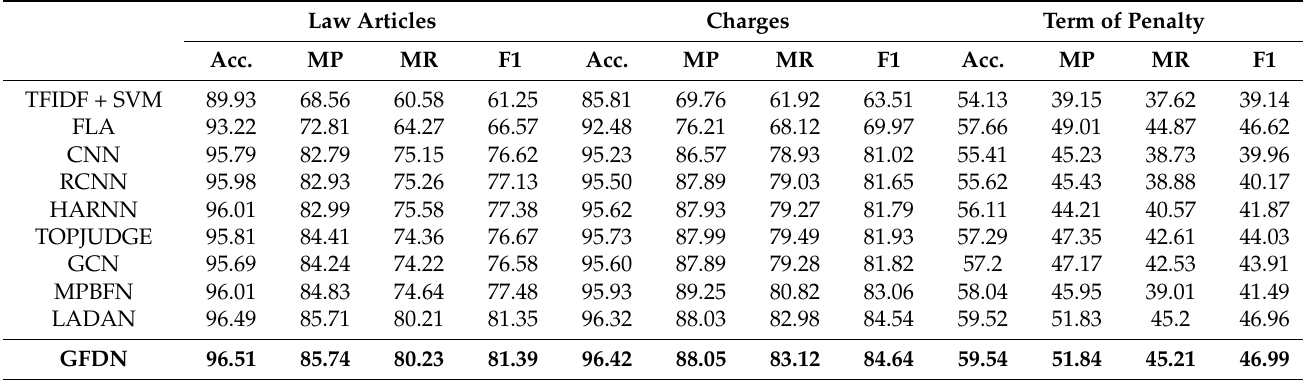
Table 4. LJP results on dataset CAIL-big.